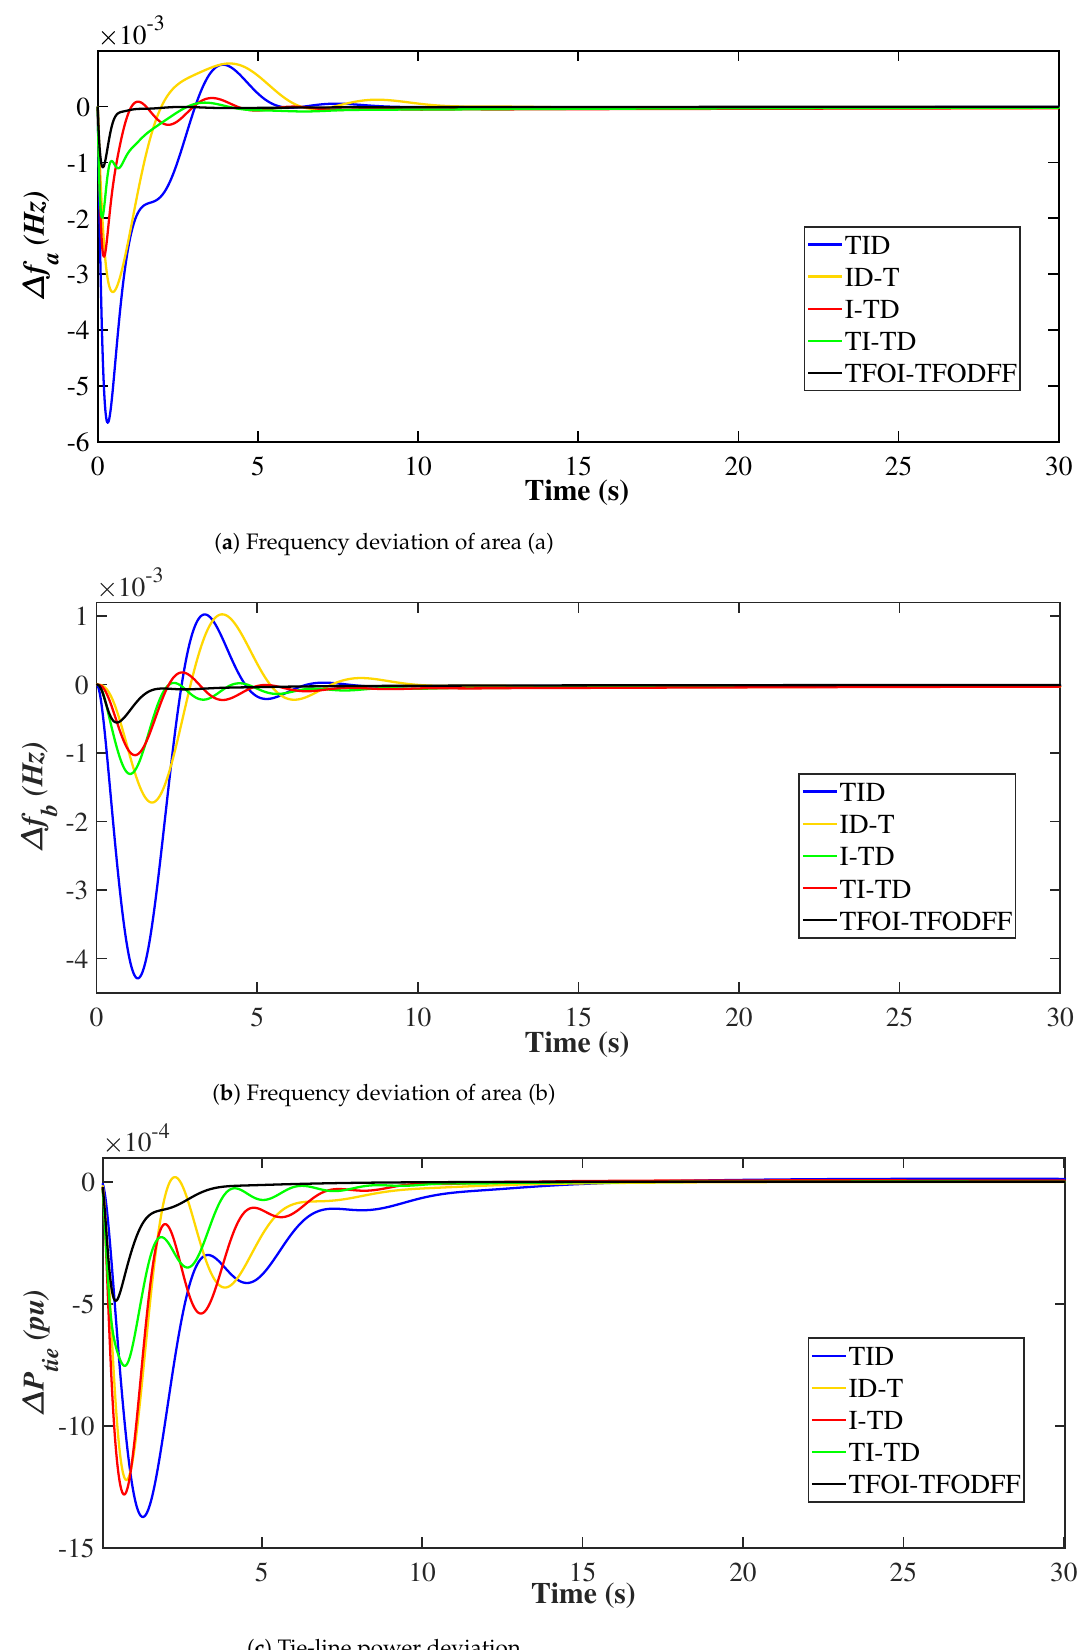
Figure 12. The dynamic response of the system to scenario